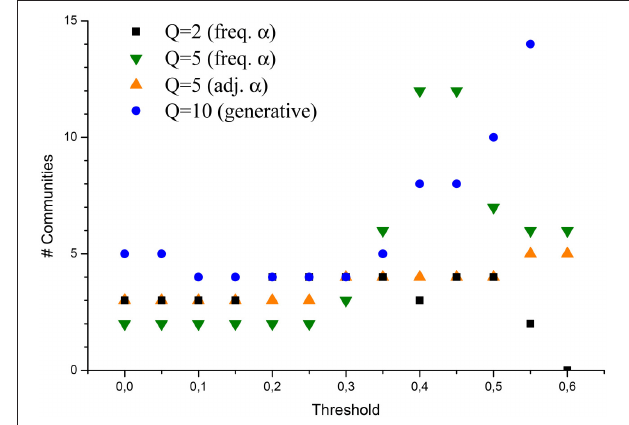
FIGURE 2 | Number of communities detected in the network via the CNM algorithm, applied to various LBP reconstructed networks. the number of such communities depends on t m : the plot